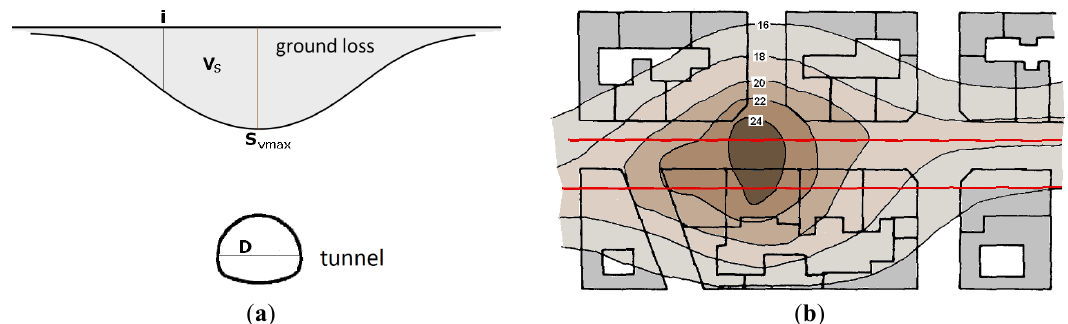
Figure 4. ( a ) Idealized pattern of ground loss, which can be approximated by a Gaussian curve, defined by two parameters, S v max and i ; ( b ) typical subsidence trough during the excavation of the Budapest Metro (after [23], modified). Subsidence follows the pattern of Equation (1), but along the trough, the amplitude of subsidence (shown by contours, in cm) is variable and ‘bowls’ of increased subsidence are formed.